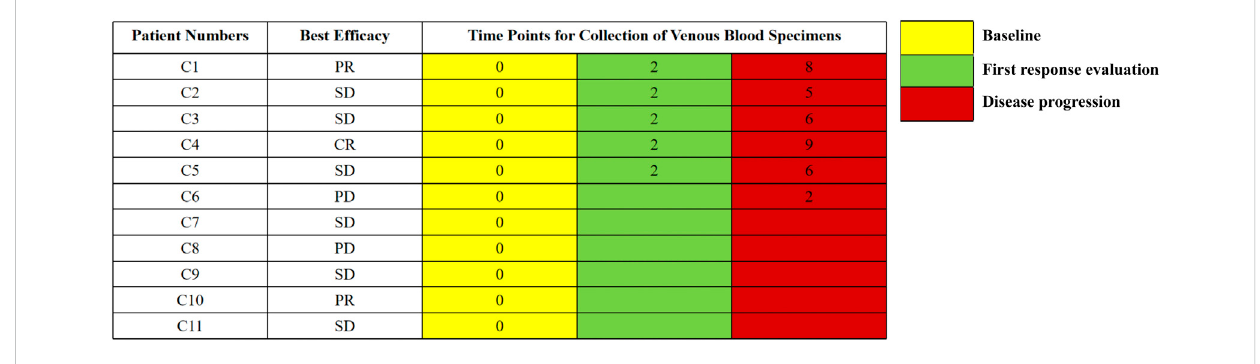
FIGURE 1 The timepoints for collection of venous blood specimens. The numbers represent the cycles of